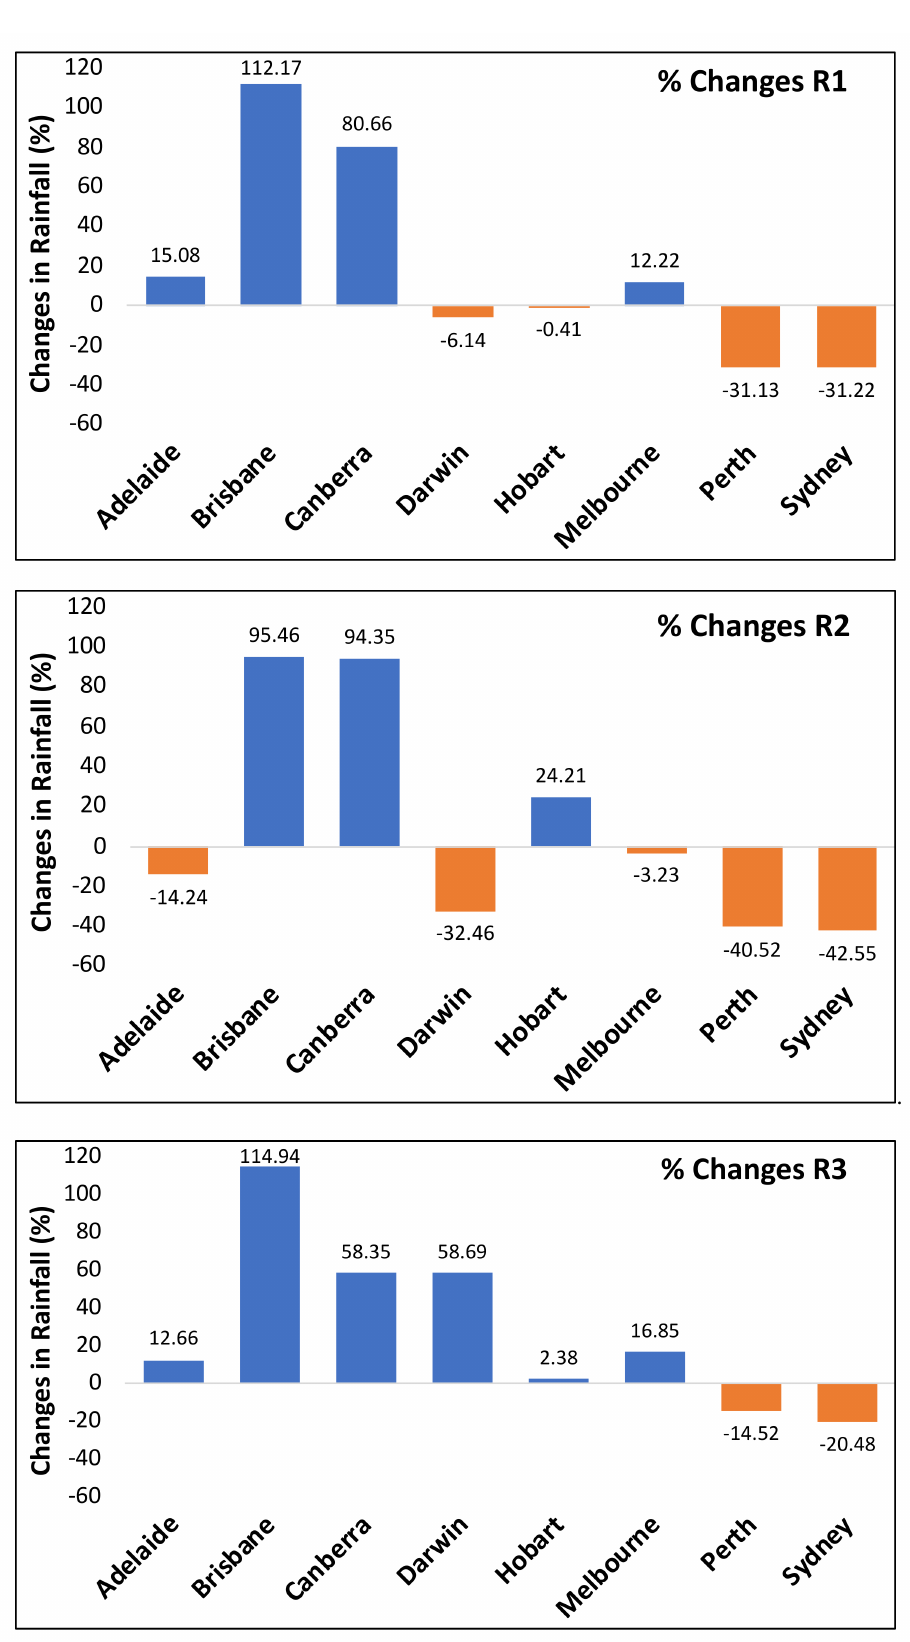
Figure 3. Plots showing percent changes in average annual rainfall values for R1, R2, and R3 in comparison to the historical